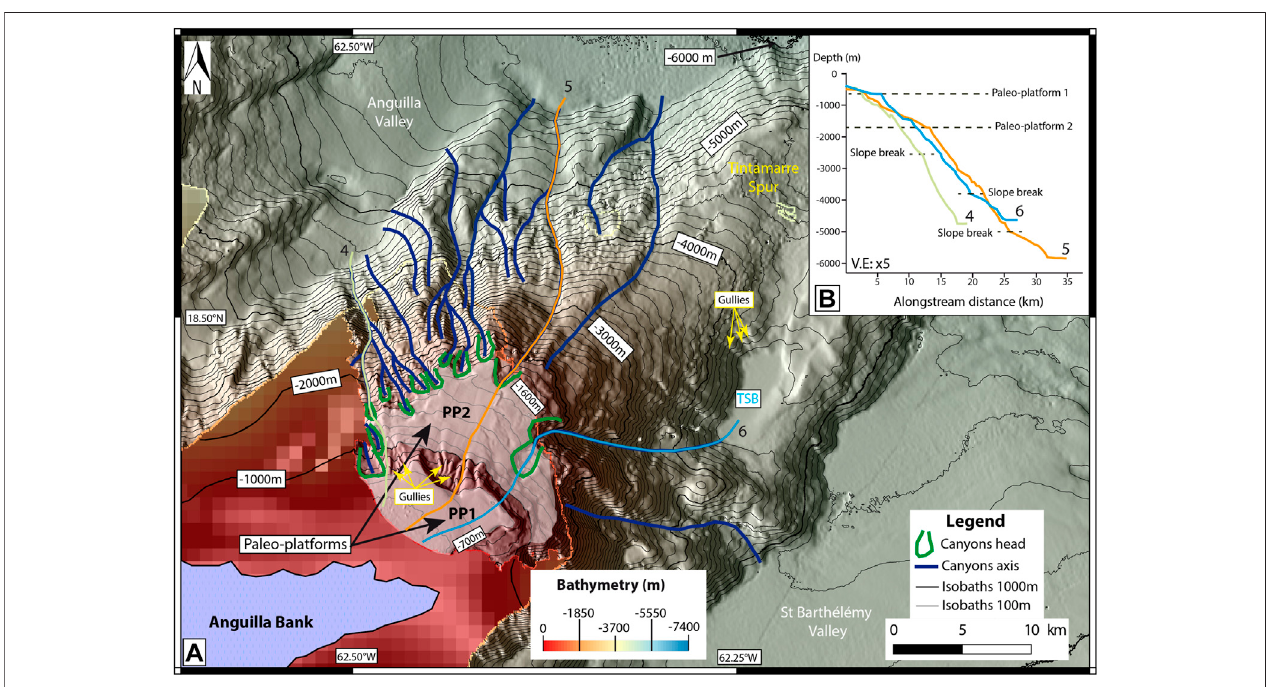
FIGURE 8 | (A) Enlargement of the Tintamarre Spur. PP1: Paleo-platform 1; PP2: Paleo-platform 2; TSB: Tintamarre Spur Basin. Three canyons axis (4, 5, and 6) are represented and referred to Figure 8B . Please note that canyons are more numerous in the northern part of the Tintamarre Spur than in the southern part. (B) Bathymetric pro fi les of three canyons axis (4, 5, and